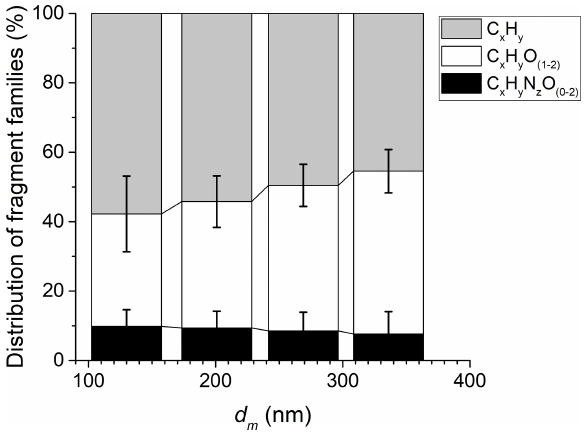
Figure 6. Mass fractions of the three main sets of organic fragments present in AS particles as measured by the HR-ToF-AMS during EXP P1. The error bars represent the standard deviation from aver- aging multiple